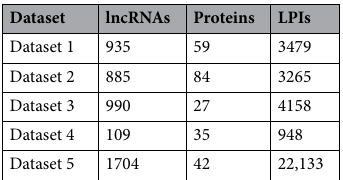
Table 10. The details of LPI